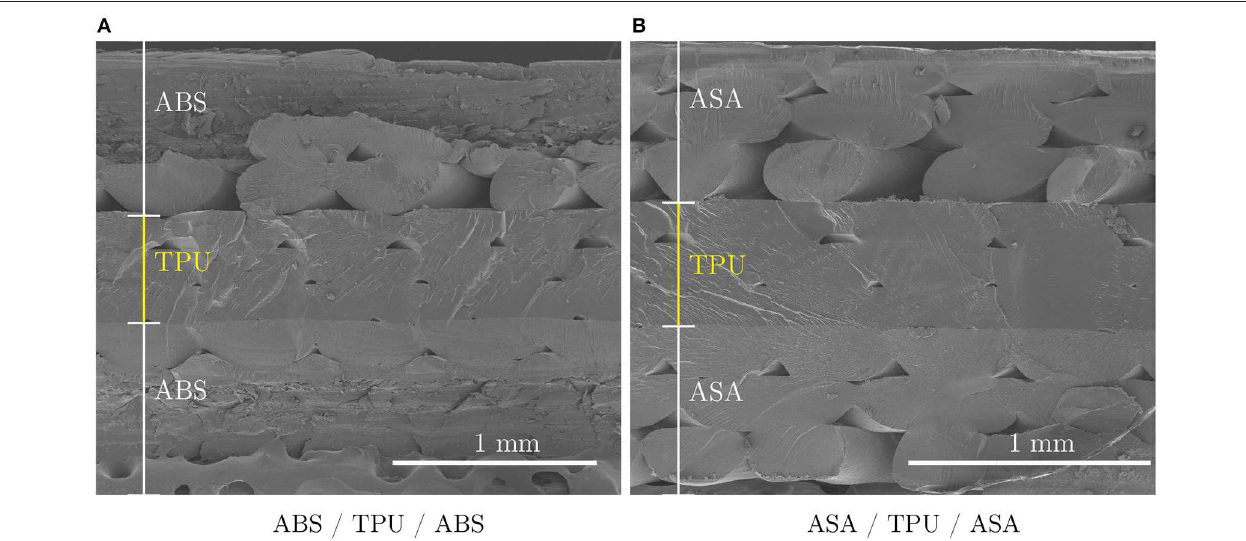
FIGURE 4 | SEM images of TPU composites along the cross-section. (A) Composite of ABS / TPU / ABS. (B) Composite of ASA / TPU / ASA. The images reveal a more flush interface for adhesion between the TPU layers and bottom layers, as the bottom interface is coalesced and flush. In turn, the adhesion between the TPU layers and top layers are less than ideal, as the top layer contains holes, which could be a product of higher moduli at print